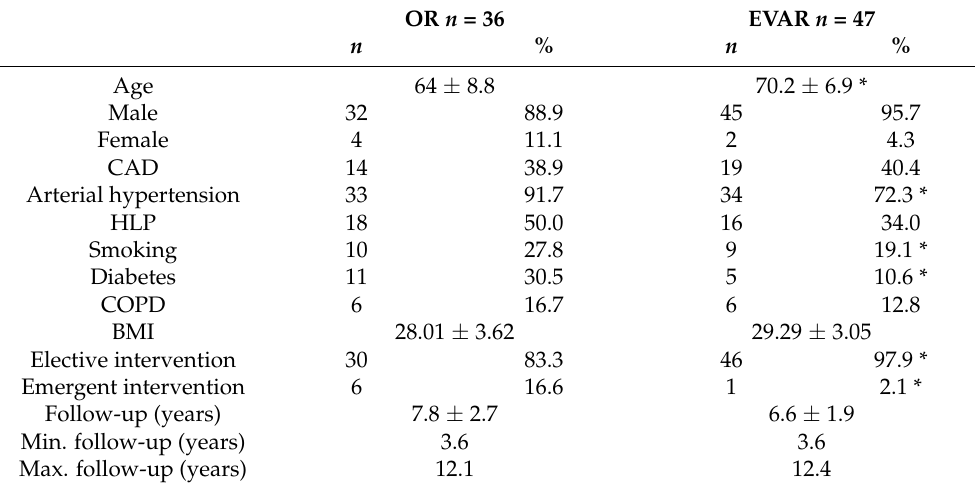
Table 1. Baseline characteristics at the time of data collection and follow-up time of patients after open repair or endovascular aortic repair of an abdominal aortic aneurysm. Data are given as n (%) or mean ± SD. Fisher’s exact